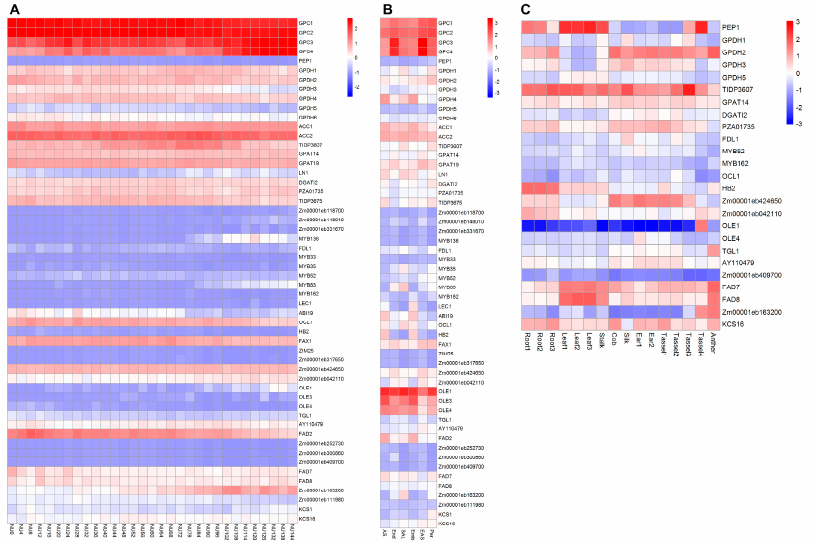
Figure 5. Expression profiles of potential gene resources for maize lipid content improvement. ( A ) Expression heatmap of potential gene resources for maize lipid content improvement from maize nucellus at different time points after pollination. NU0-144 represents the nucellus (embryo sac included) after 0–144 h of self-pollination. ( B ) Expression heatmap of potential gene resources for maize lipid content improvement from maize kernels. AS, Apical scutellum; End, Endosperm; SAL, Scutellar Alleurone Layer; Emb, Embryo; EAS, Endosperm Adjacent to Scutellum; Per, Pericarp. ( C ) Expression heatmap of potential gene resources for maize lipid content improvement from 16 maize tissues. Root1,2,3 represent V2, V5 seminal root and adult nodal root, respectively; Leaf1,2,3 represent the 2nd, 4th and 8th leaf, respectively; Ear1,2 represent V8 and V15 ear, respectively; Tassel 1,2,3,4 represent 1 mm, 2 cm, 12 cm and 22 cm tassel, respectively. The color scale bars represent the relative expression